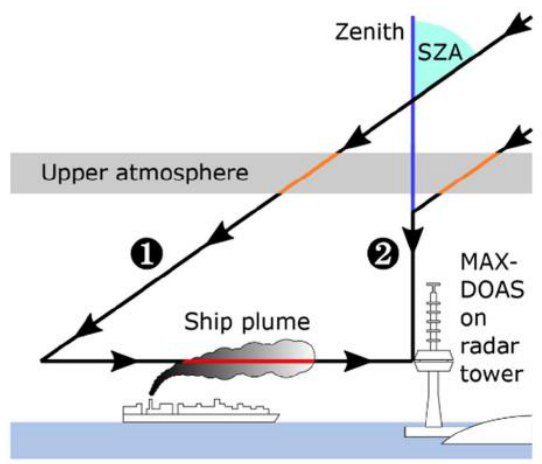
Figure 3. MAX-DOAS monitoring of ship emissions (Reproduced from [51] under the terms and conditions of a CC-BY copyright license agreement).